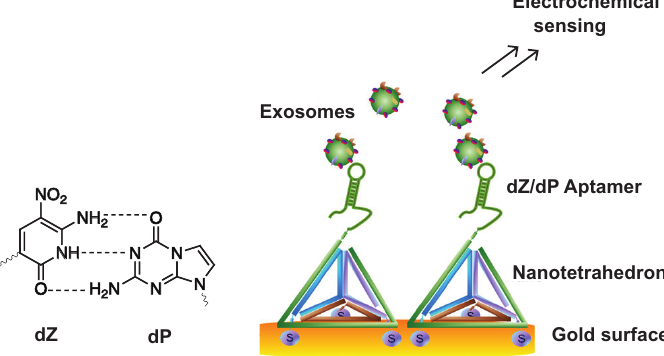
Figure 5. Structure of the dDs and dPx unnatural base pairs ( left ). Illustration of competitive ( A ) and sandwich ELONA assays for the recognition of the proteins VEGF-165 and INF- γ using immobilized antibody ( B ) and immobilized dDs-modified aptamer ( C ) ( right ).